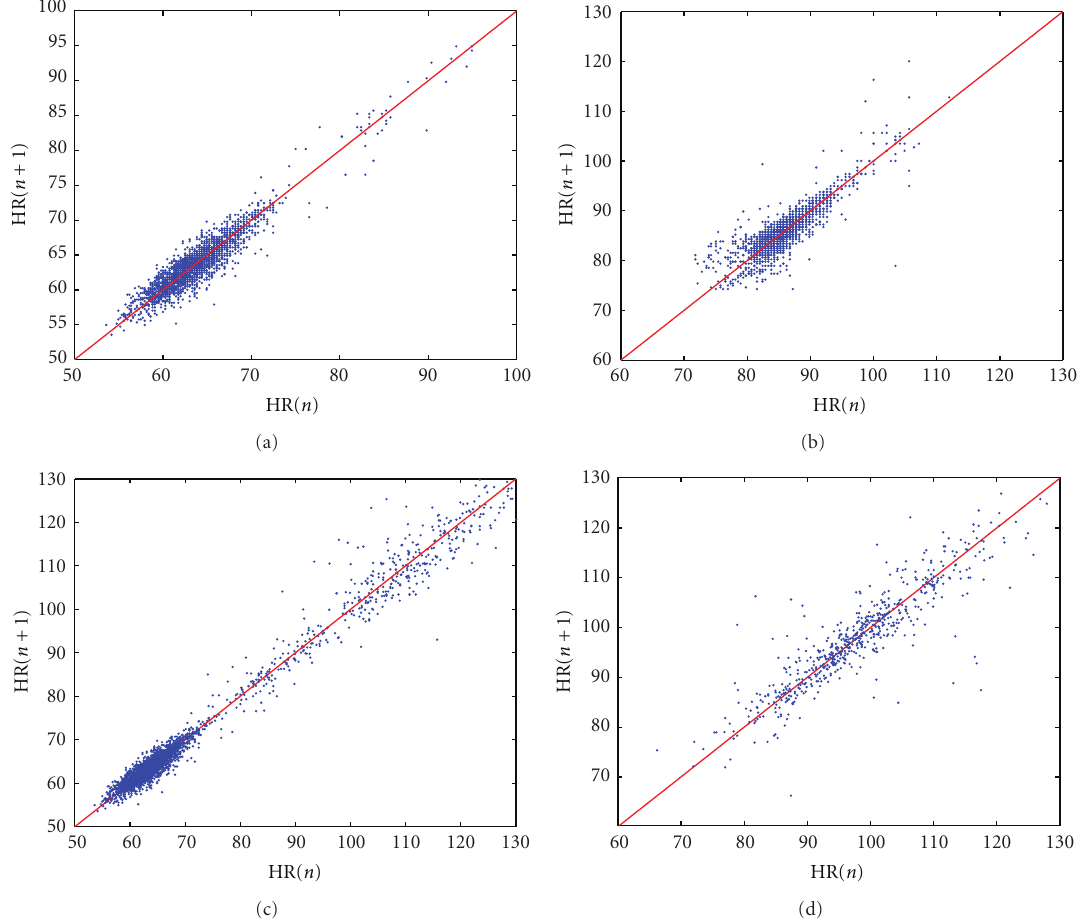
Figure 4: Poincare plots of HR for two healthy (up) and two abnormal (down) cases. The Poincare plot is plot of HR( n + 1) versus HR( n ). Line y = x is illustrated in all pictures.